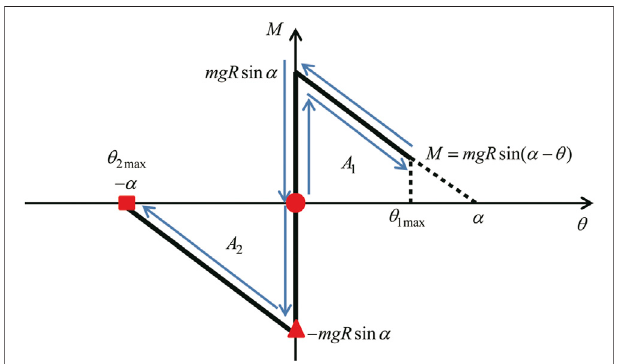
FIGURE 7 | Moment-rotation relation for rocking response of rigid block and limit of overturning (Nabeshima et al., 2016).